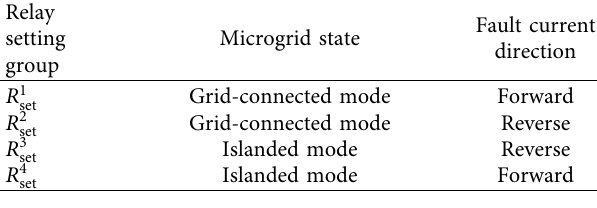
Table 1: A relay setting group for each system state.